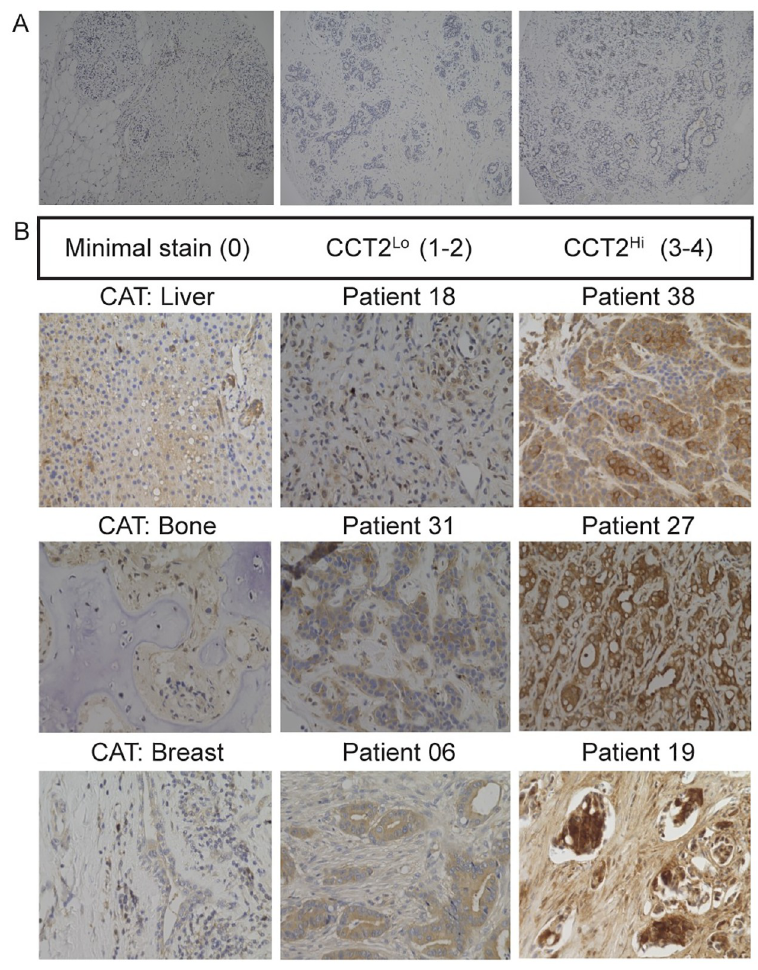
Fig 2. Histological analysis of CCT2 in normal tissue vs. metastatic breast cancer (MBC) patients. (A) Representative images from tissue microarray of normal breast tissue stained for CCT2. (B) Representative images from a cohort of MBC patient tissues (breast and metastatic sites; S4 Table) stained for CCT2. The images are—Left column: cancer adjacent tissue (CAT) from locations indicated in the figure, which had minimal staining. Middle column: CCT2 lo tissue, which was classified as a score of 1 or 2. Right column: CCT2 hi tissue, which was classified as a score of 3 or